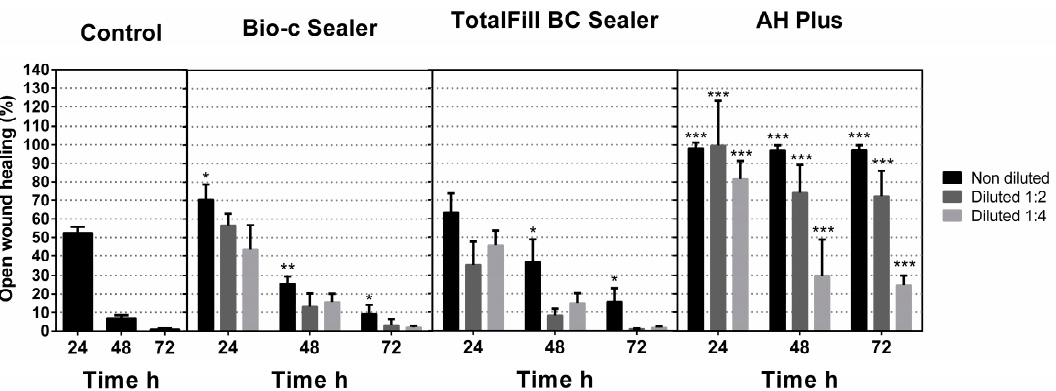
Figure 2. Cell migration of hPDLSCs by scratch wound test using extraction media derived from the set sealers at 24 h for up to 72 h. Cell migration is represented as the percentage of the open wound area for each condition compared with the control. Significant differences are indicated as *p < 0.05; **p < 0.01; ***p < 0.001, respectively.